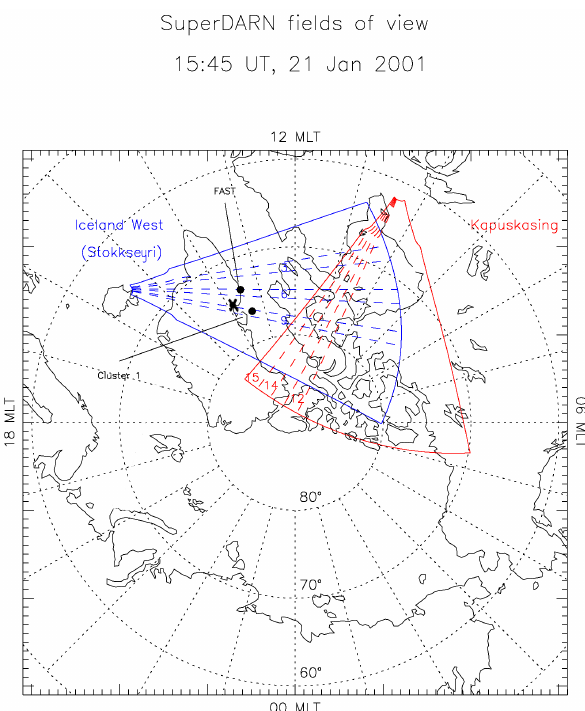
Fig. 4. The fields of view of two SuperDARN radars (Iceland West (violet) and Kapuskasing (red) in an MLAT-MLT format. The map refers to 15:45 UT, the center of the conjunction interval. Also shown are the footprints of FAST and Cluster 1 and the location of the Søndrestrom radar station. Fig. 5. Cluster/FGM and CIS data for 13:00–18:00 UT. Plotted are